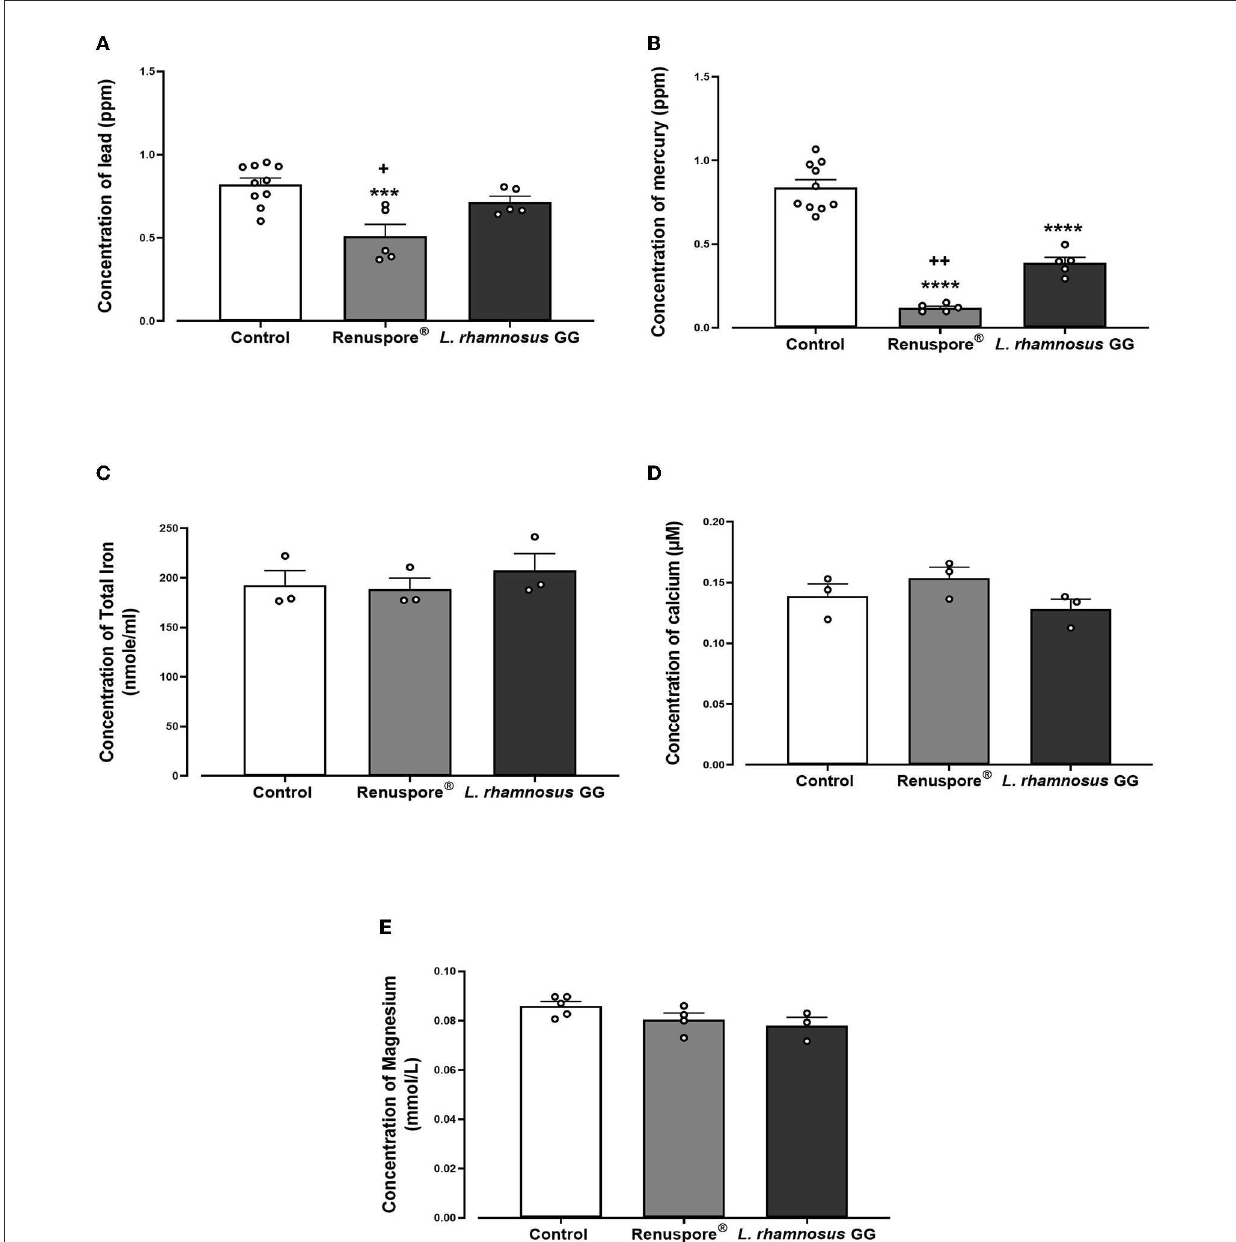
FIGURE3 Renuspore ® significantly decreased the concentration of (A) lead and (B) mercury compared with L. rhamnosus GG. The results show average concentration ( n = 5) ± standard error. Renuspore ® does not bioaccumulate (C) iron, (D) calcium, and (E) magnesium. The results show average concentration ( n = 3) ± standard error. Significant difference observed between Renuspore ® and control is indicated: *** p < 0.001 and **** p < 0.0001. Significant reduction observed between Renuspore ® and L. rhamnosus GG is indicated: + p < 0.05 and ++ p < 0.01. The results were statistically analyzed using the one-way analysis of variance (ANOVA) (biological replicates n = 3 or 5) followed by Tukey’s multiple comparison test using GraphPad Prism